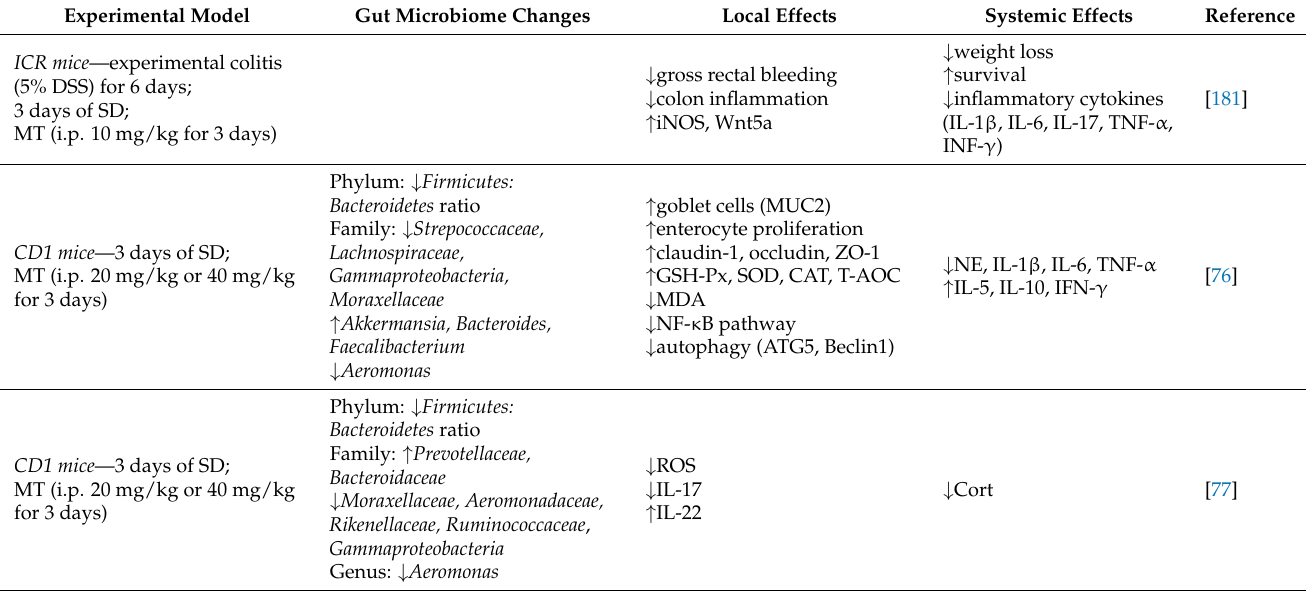
Table 3. Evidence from animal studies to support the impact of melatonin on the gut microbiome and its local and systemic effects on sleep disturbance-associated